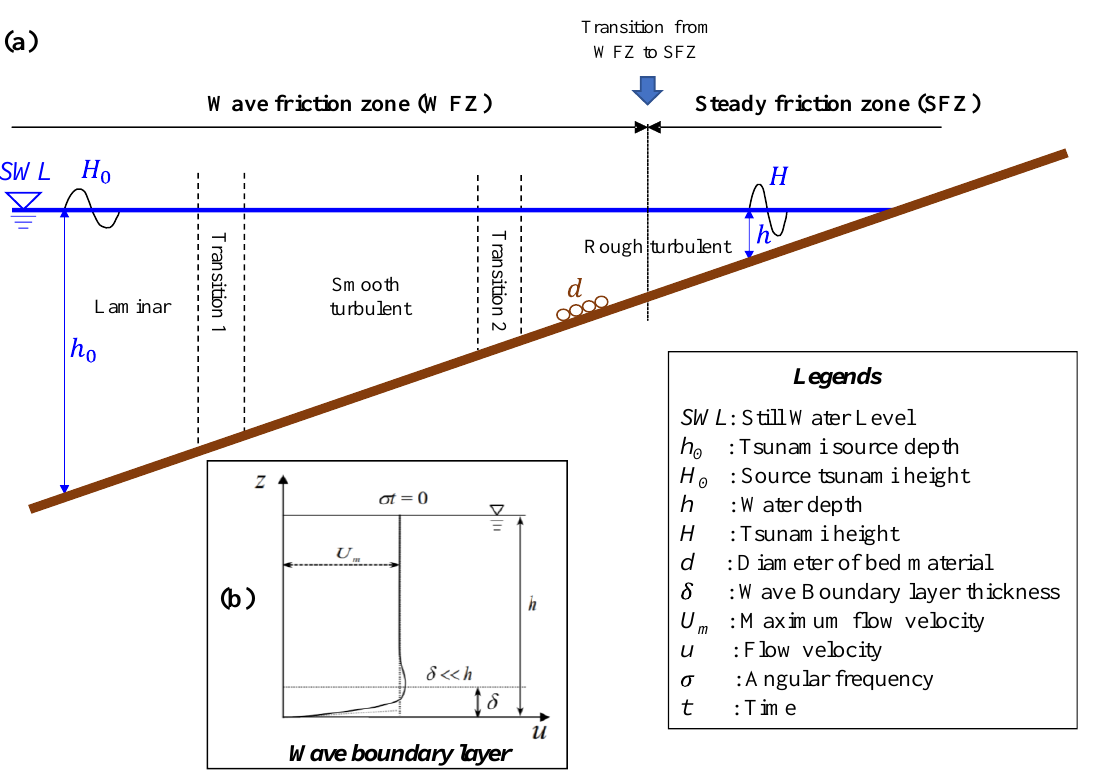
Figure 1a: (1) transition of flow regime in a wave boundary layer (Figure 1b) [21,22], and (2) transition from wave friction zone (WFZ) to steady friction zone (SFZ) [20,23]. In this study, the wave boundary layer thickness is defined based on Jensen et al. [4] as illustrated in Figure 1b.